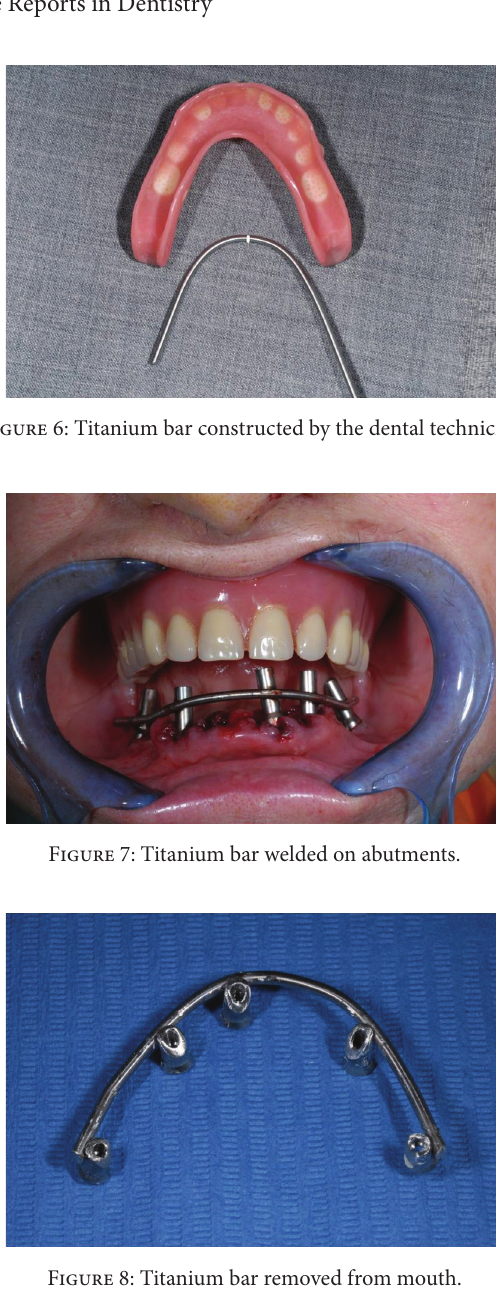
Figure 12: Final restoration.